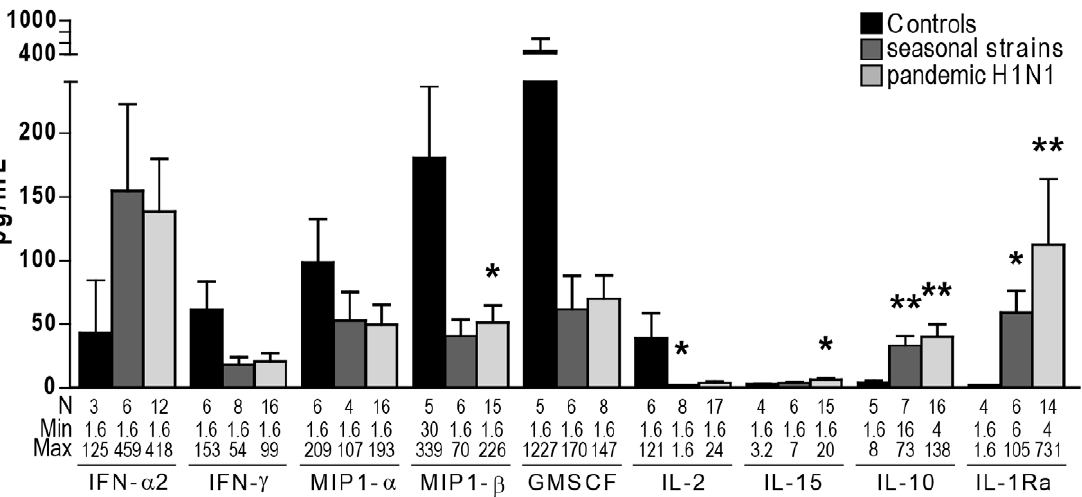
Figure 5. Changes in plasma cytokine concentrations associated with acute influenza infection. Columns represent mean concentrations of indicated cytokines in 7 controls (black), 9 patients with acute seasonal influenza (dark grey) and 21 with acute 2009 pandemic H1N1 influenza (light grey). For each column, N represents the number of values included in the analysis based on a coefficient of variation , 30. Low out of range values were set to half of the lowest standard value (1.6 pg/mL). Bars indicate standard error of the mean. * represents p , 0.05; ** represents p , 0.001 and *** represents p , 0.0001.